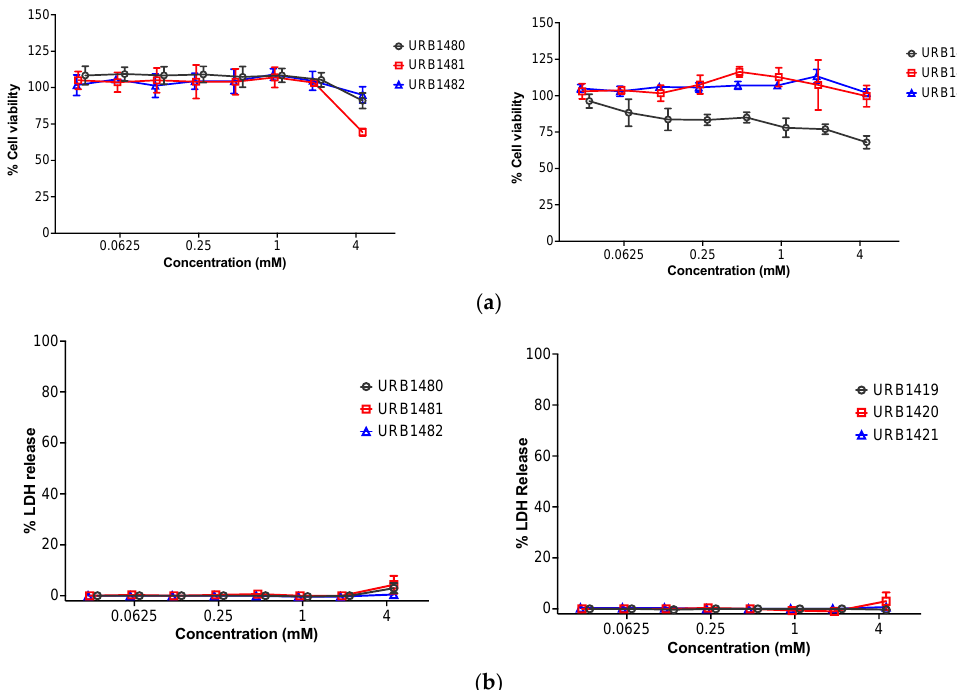
Figure 3. ( a ) MTT cell viability study of sucrose-based surfactants (URB1480-URB1482) and lactose- based surfactants (URB1419-URB1421) on Calu-3 cells. The values reported are the mean ± SD of three independent experiments. ( b ) LDH release study of sucrose-based surfactants (URB1480- URB1482) and lactose-based surfactants (URB1419-URB1421) on Calu-3 cells. The values reported are the mean ± SD of three independent